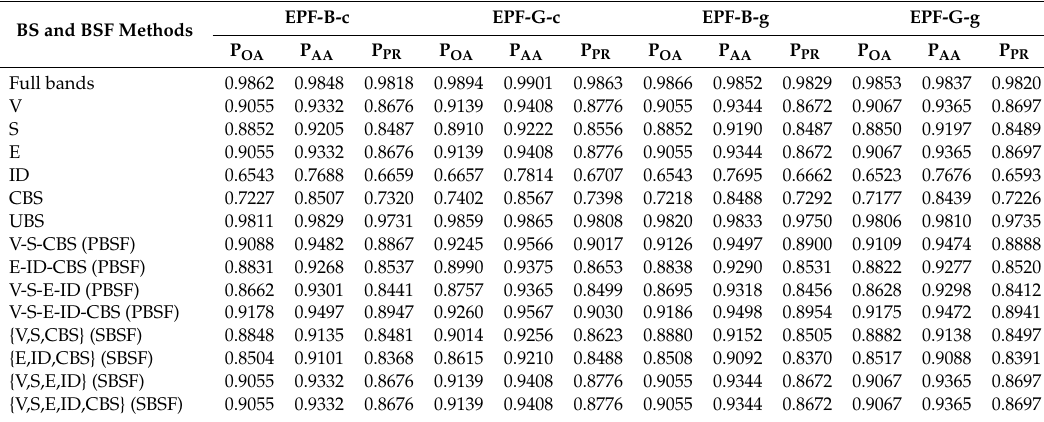
Table A2. P OA , P AA , and P PR for University of Pavia produced by EPF-B-c, EPF-G-c, EPF-B-g, and EPF-G-g using full bands and bands selected in Table 7.